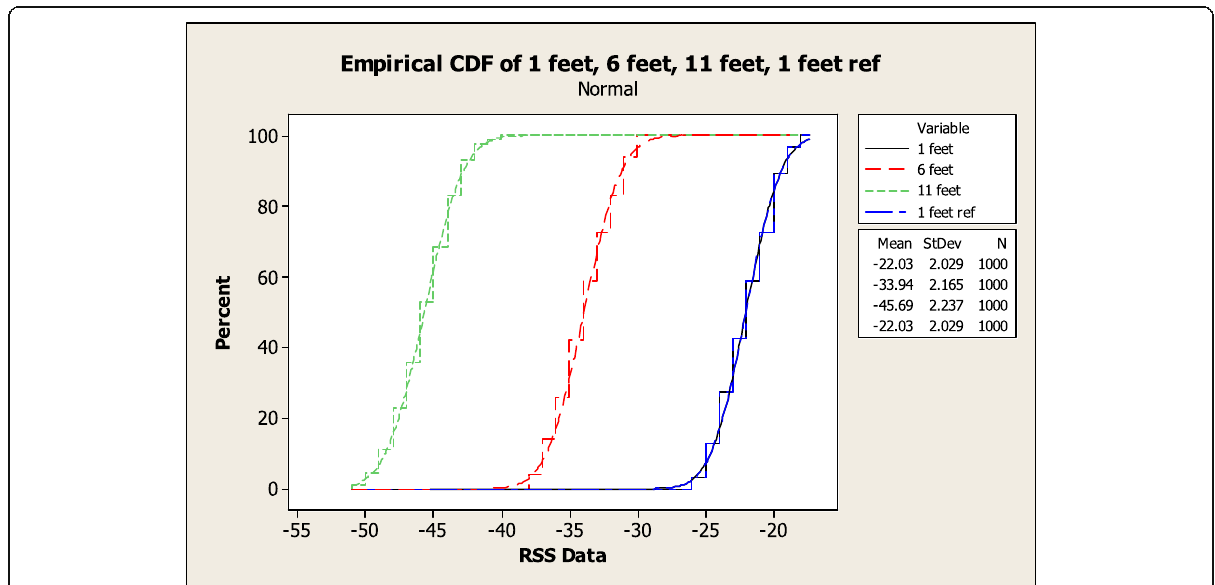
Fig. 2 Empirical CDF of scenario I. Calculates the empirical cumulative distribution functions for 1, 5 and 11 ft. The x -axis represents the RSS data while the y -axis represents the percentage value of each graph. It also shows the mean and standard deviation values of the three instances taken in scenario I